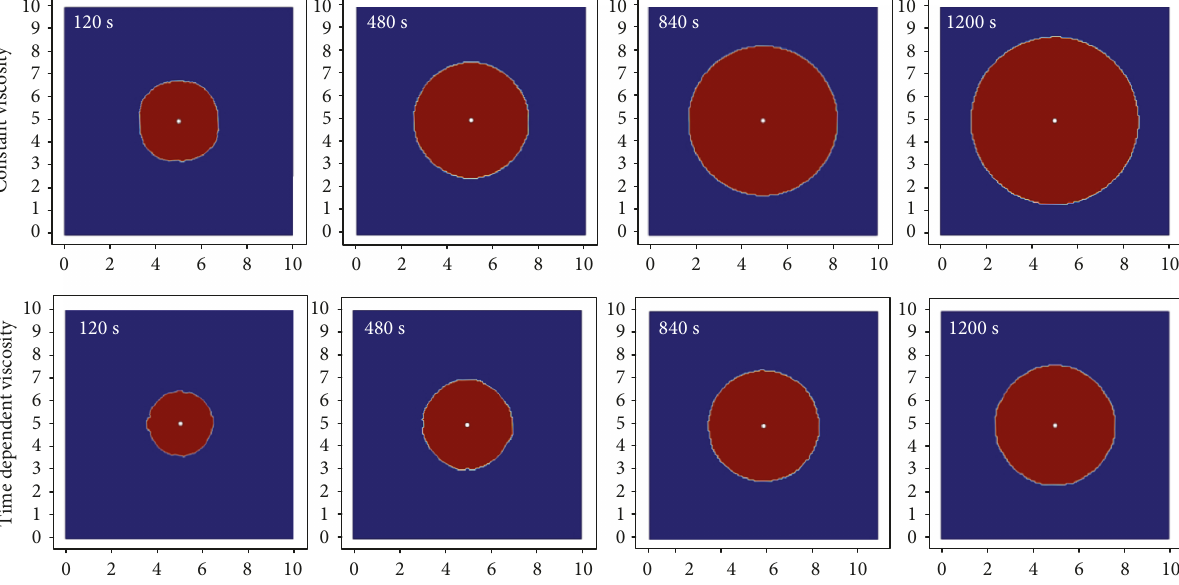
Figure 14: Permeation di ff usion range of viscosity time-varying (W:C =7: 1, p = 2 MPa) and nonviscosity time-varying (0.3Pa · s, p = 2 MPa) expandable slurries with high water